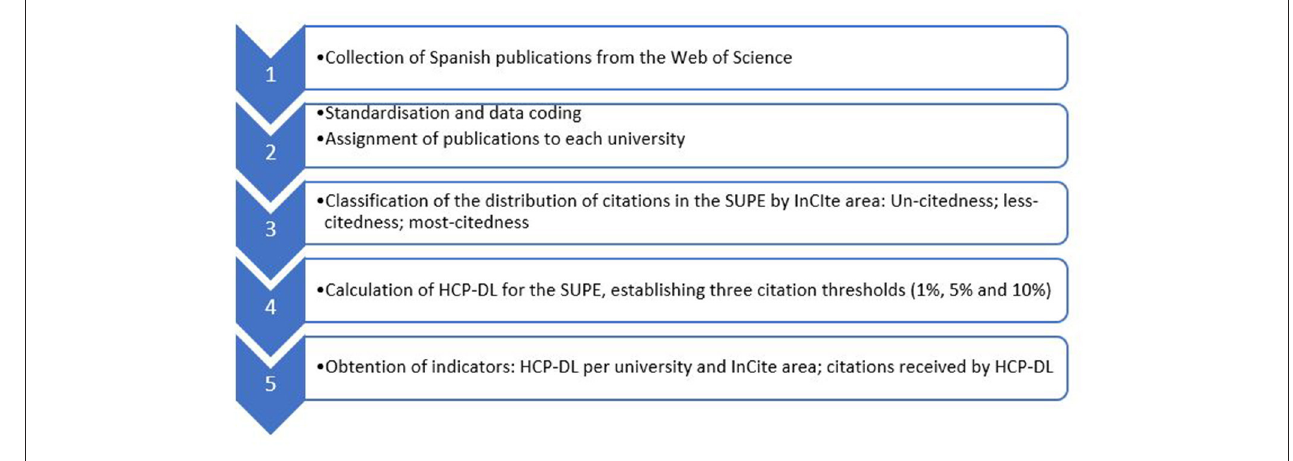
FIGURE 1 | Methodological steps.